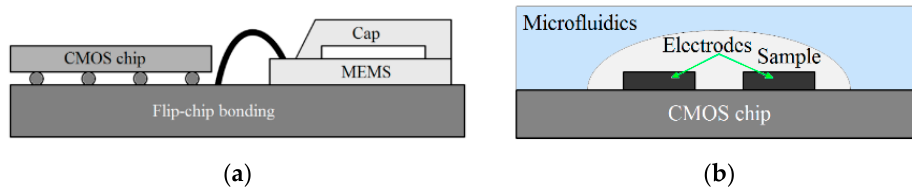
Figure 1. ( a ) Conceptual view of wire-bonded electrodes used for microelectromechanical systems (MEMS) applications, ( b ) conceptual view of on-chip electrodes used for Laboratory on a Chip (LoC) applications.